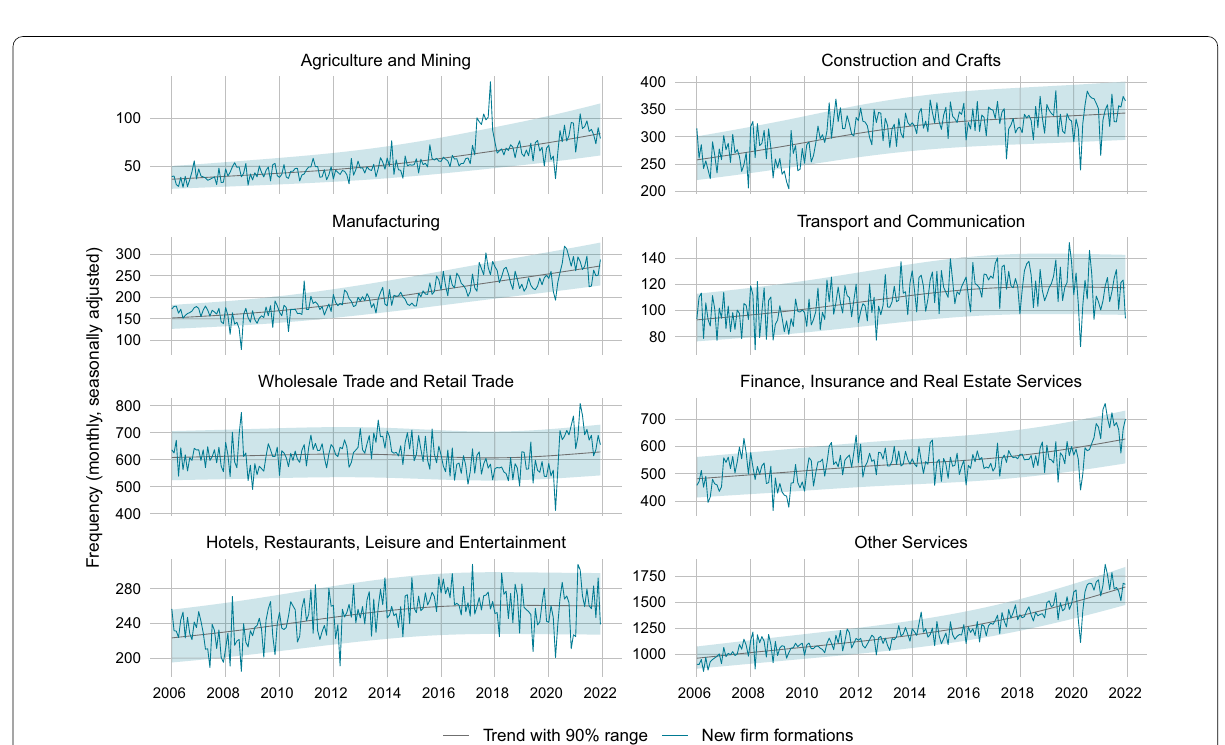
Fig. 20 Monthly frequency of firm start-ups at the sectoral level. Notes : The figure shows the monthly seasonally adjusted frequency of new firm formations in the sectors of the Swiss economy excluding SCO Art. 731b cases, together with a trend and the 90% probability range. Sectors are grouped together according to economic